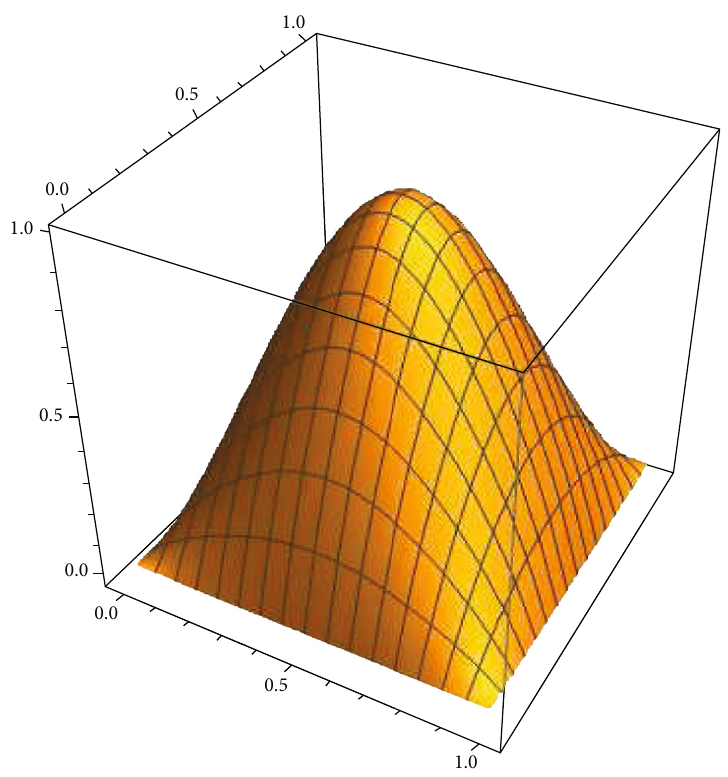
ð u , v Þ spanned by four straight lines 0 ≤ u , v ≤ 1 , reduced area is 2